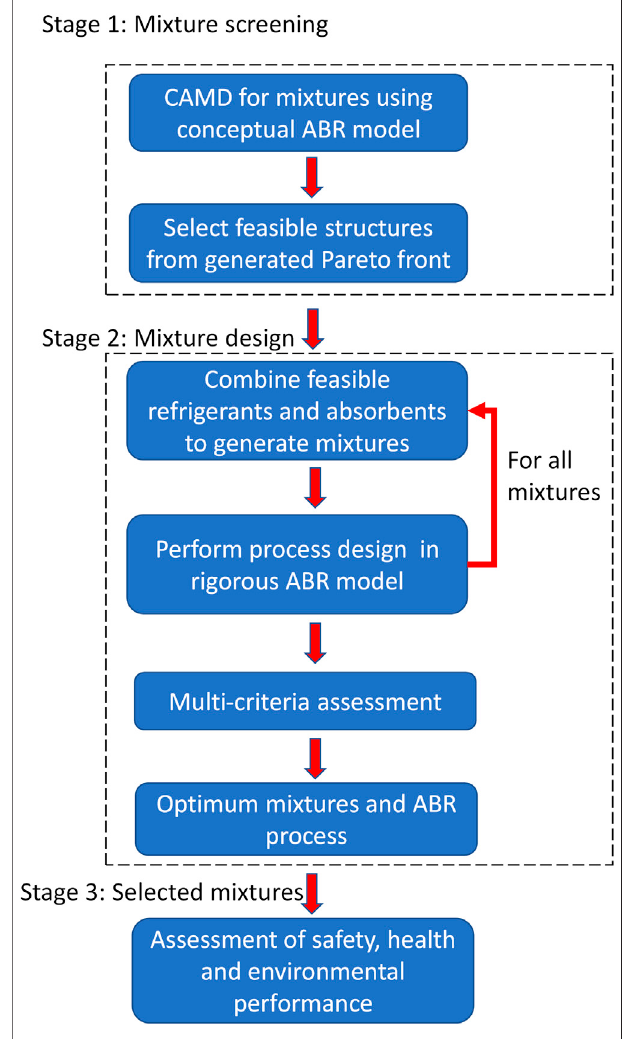
FIGURE 2 | Stages of approach proposed in this